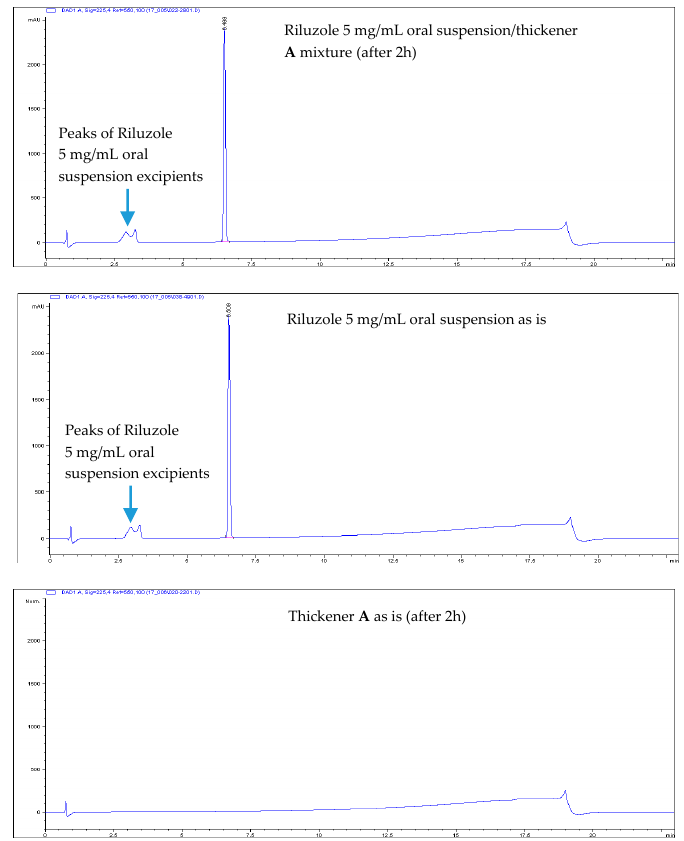
Figure 1. Comparison of chromatograms: Riluzole 5 mg / mL oral suspension / thickener A mixture (after 2 h); Riluzole 5 mg / mL oral suspension as is and Thickener A as is (after 2